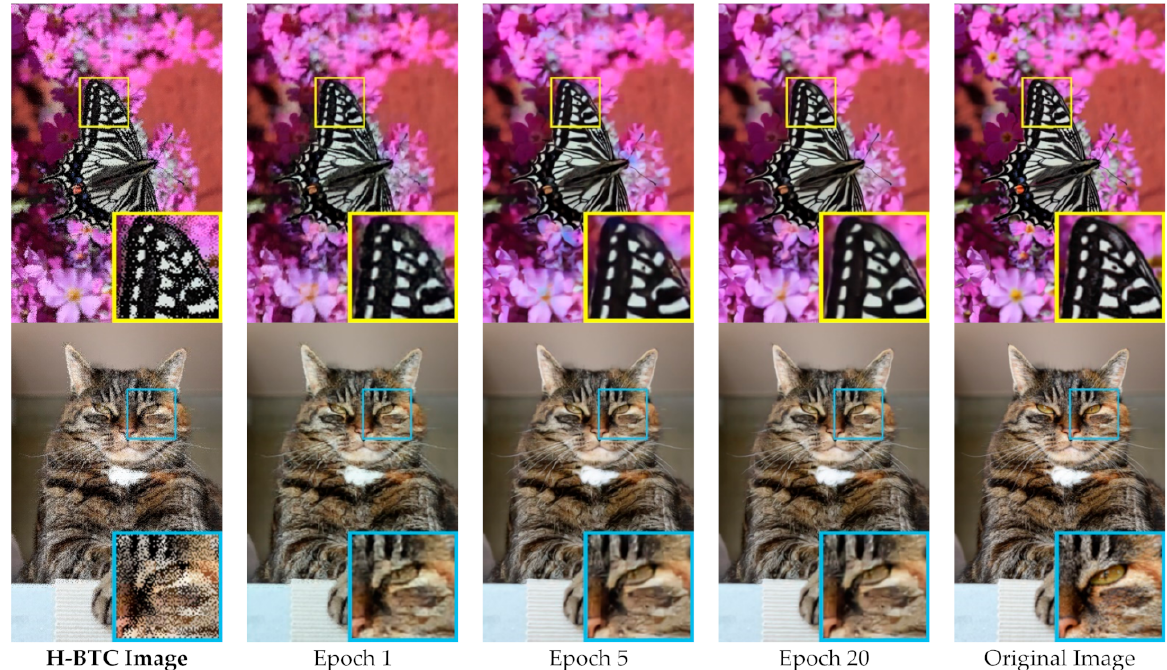
Figure 11. Image quality improvement produced by the proposed networks during the training process on the validation